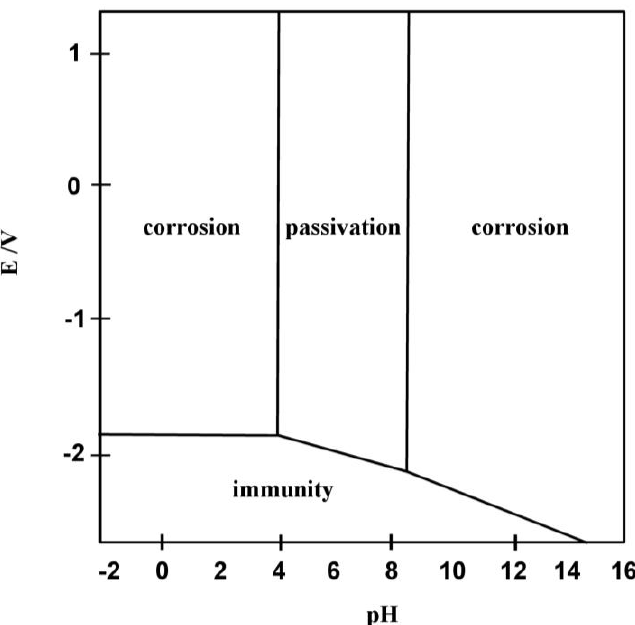
Figure 4. Pourbaix diagram for aluminium. This is derived from the Nernst equation and is used to show the regions of thermodynamic stability for a metal/electrolyte interface as pH versus electrode potential, E